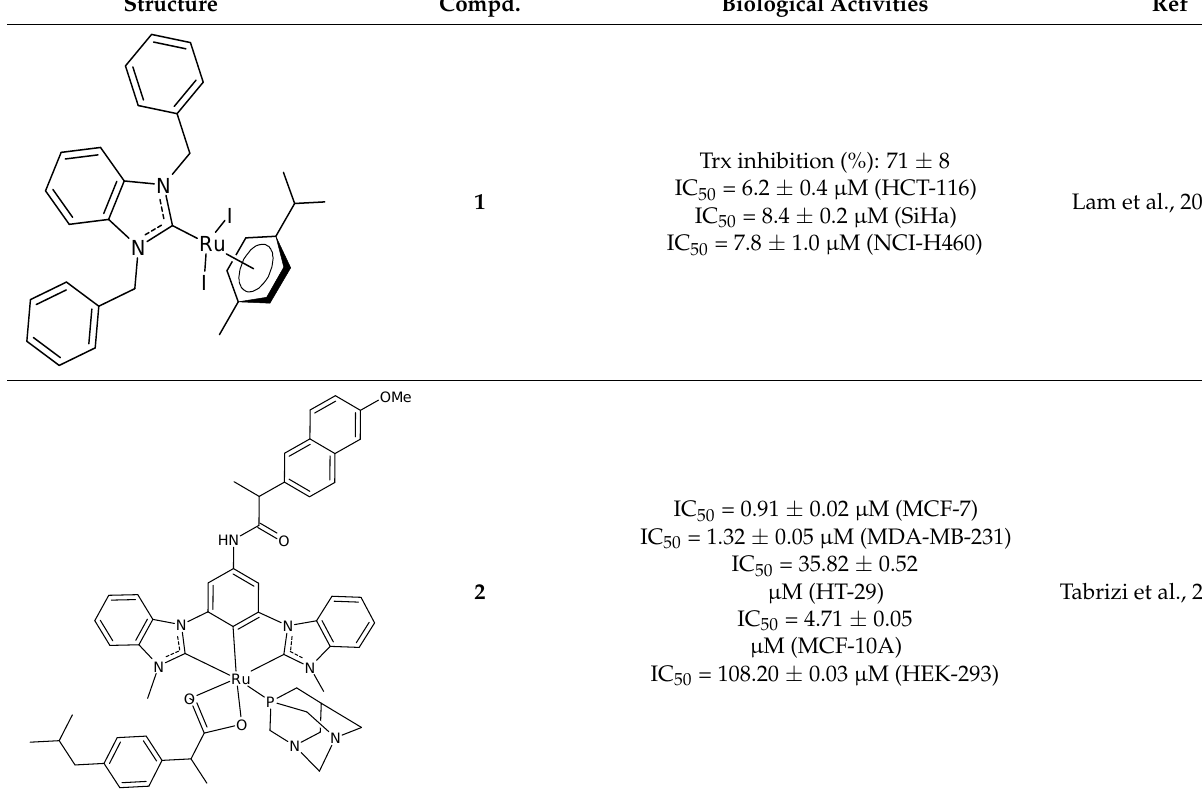
Table 1. Antiproliferative activity of Ru(II)-NHC complexes. Compd. Structure